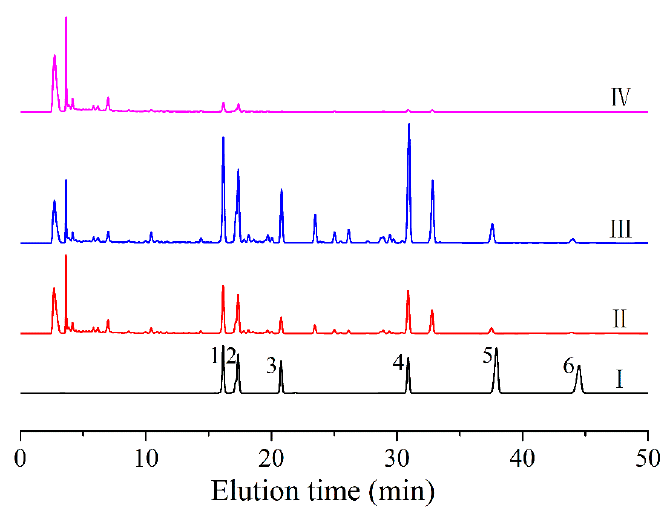
Figure 3. HPLC chromatograms of anthraquinones in standard solution (I), feed solution (II) foamate (III) and residual solution (IV). The standard solution had six anthraquinones of 1-urantio-obtusifolin, 2-aloe-emodin, 3-rhein, 4-emodin, 5-chrysophanol, and 6-physcion. Table 4. Enrichment ratios and recovery yields of urantio-obtusifolin, aloe-emodin, rhein, emodin, chrysophanol, and physcion calculated on the basis of the data in Figure 3. Aurantio-Obtusifolin Aloe-Emodin Rhein Emodin